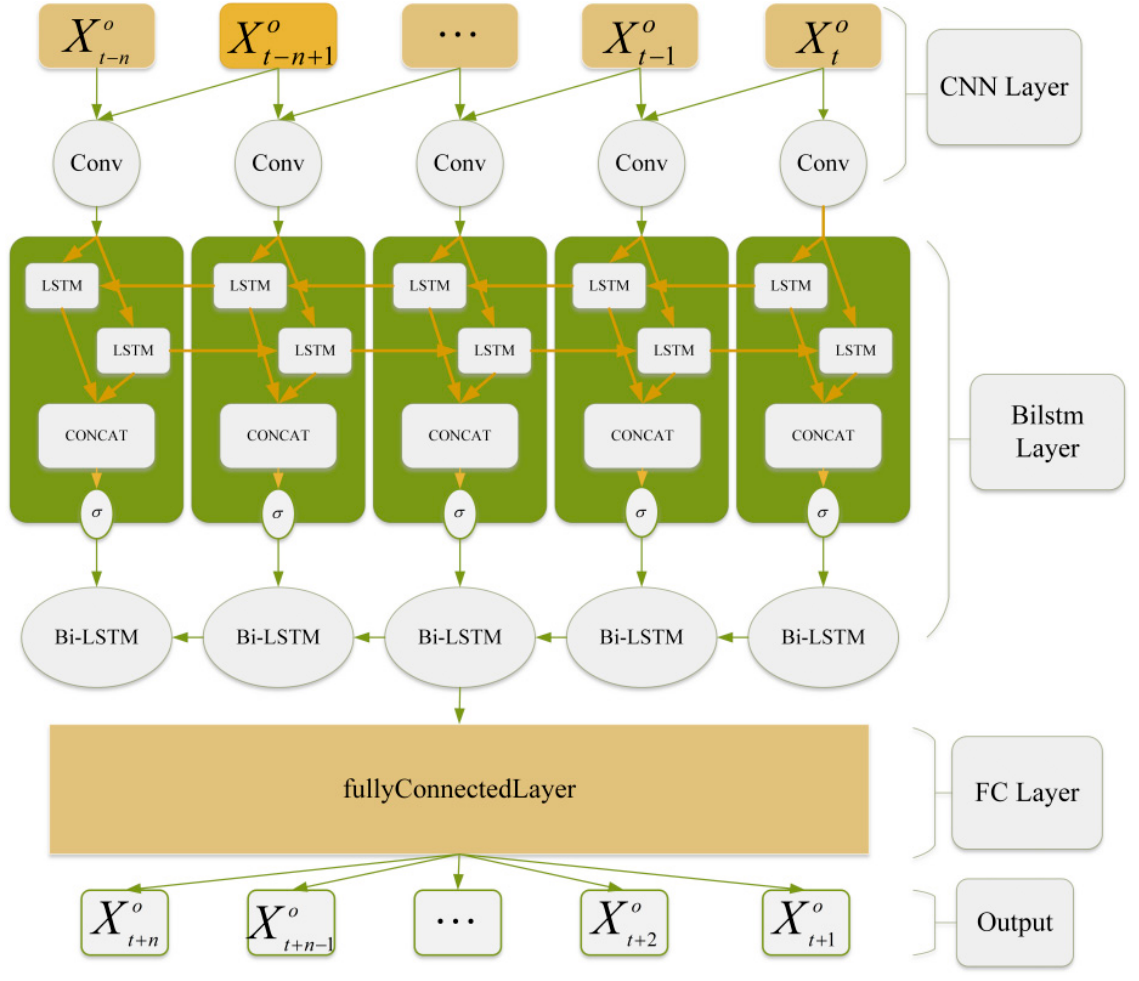
Figure 3. CNN − BILSTM algorithm framework diagram.